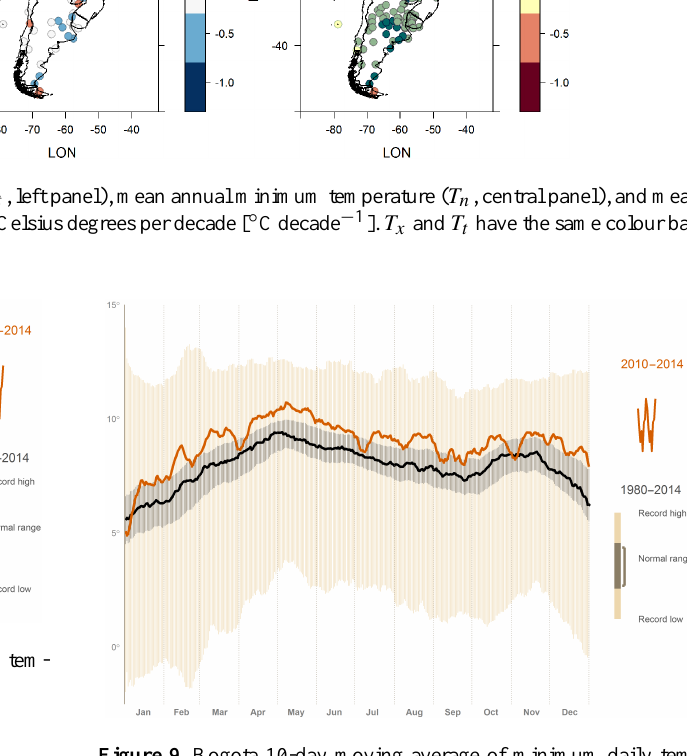
Figure 9. Bogota 10-day moving average of minimum daily tem- perature (2010–2014 versus 1980–2014